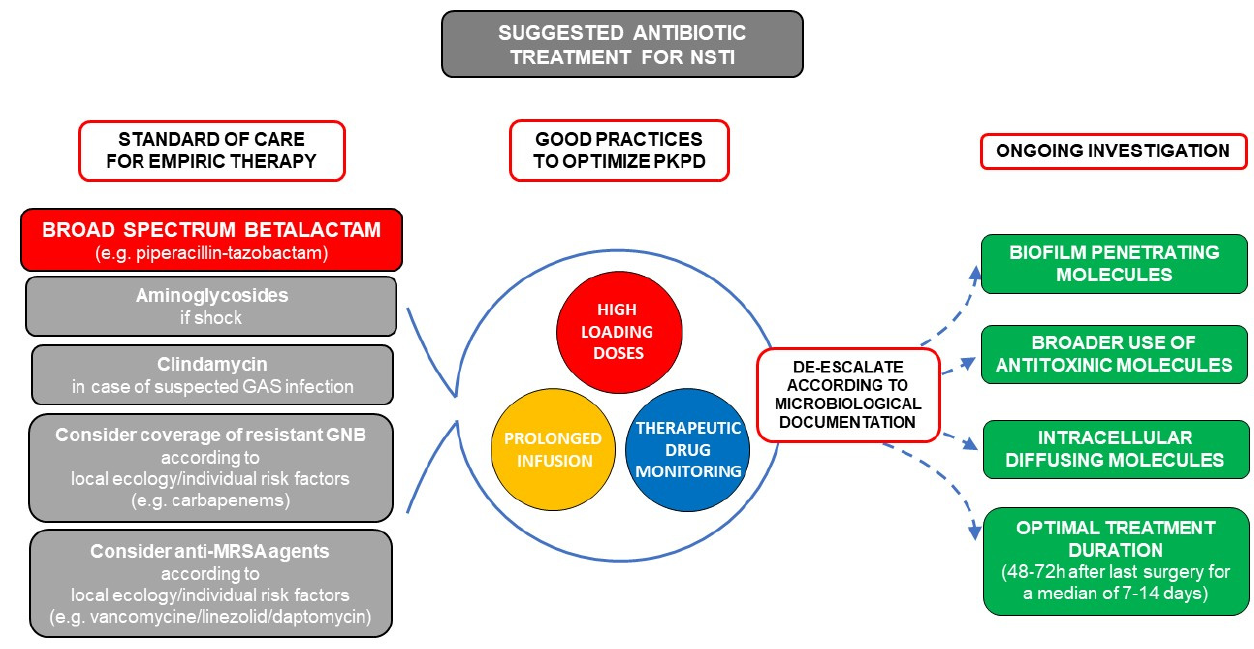
Figure 2. Suggested antibiotic treatment for necrotizing soft tissue infection (NSTI) and future perspectives. The mainstem of empiric treatment is a broad-spectrum beta-lactam (e.g., piperacillin-tazobactam) with additional aminoglycosides in case of septic shock. Clindamycin should be added in case of documented or suspected group A streptococcus (GAS) infection (limb infection, features of streptococcal toxic shock, absence of comorbidities, blunt trauma, absence of chronic skin lesions, homelessness, injectable drug use, non-steroidal anti-inflammatory drug use). Coverage of resistant gram-negative bacilli by carbapenems should be used according to local ecology and individual risk factors (hospital acquired infection, beta-lactam, or quinolone exposure in the previous 3 months, history of extended spectrum beta-lactamase (ESBL) carrying, germ colonization/infection or travel to high ESBL endemicity aeras in the previous 3 months). Similarly, use of anti-methicillin resistant Staphylococcus aureus (MRSA) drugs such as vancomycin, linezolid, or daptomycin should be considered in case of local endemicity, residence in a long-stay care facility, chronic dialysis, permanent transcutaneous medical devices or prior MRSA infection/colonization. Pharmacokinetics (PK) and Pharmacodynamics (PD) should be optimized by use of high-loading doses and prolonged infusions for molecules with time-dependent bactericidal activity such as beta-lactams, and therapeutic drug monitoring should be used when available.